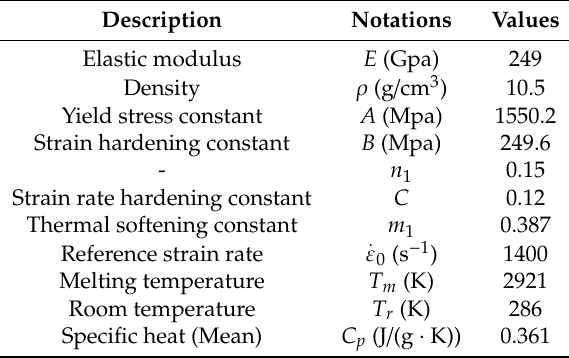
Figure 14. Calibration of J–C constitutive parameters of Mo-10Ta: ( a ) functional relationship between equivalent plastic strain and equivalent stress, ( b ) functional relationship between dimensionless strain-rate and yield strength, ( c ) functional relationship between dimensionless temperature and yield strength. Table 2. The J-C constitutive parameters of Mo-10Ta.